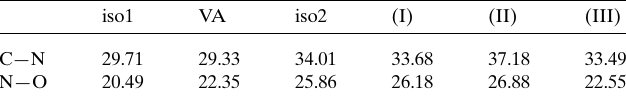
Figure 9 Distributed atomic polarizabilities of violuric acid ( a ) isolated, ( b ) taken from VA, ( c ) isolated ion, ( d ) taken from (I), ( e ) taken from (II), ( f ) taken from (III). The scaling factor is 0.4 A˚ (cid:5) 2 . Dashed lines indicate interactions with the oxime group, arrows indicate the direction of the hydrogen bond from donor to acceptor. Symmetry codes: (i) (cid:5) x + 1, (cid:5) y + 1, z + 1/2; (ii) (cid:5) x + 1/2, y (cid:5) 1/2, (cid:5) z ; (iii) x , y (cid:5) 1, z ; (iv) (cid:5) x + 1, (cid:5) y , (cid:5) z ; (v) (cid:5) x , y + 1/2, (cid:5) z + 1/2; (vi) (cid:5) x , (cid:5) y + 1, (cid:5) z + 1; and (vii) x , y + 1, z . Table 5 Bond polarizabilities for C5A–N2A and N2A–O1A in the studied compounds compared with values obtained for isolated molecules of violuric acid. Values are given in Bohr 3 . iso1 is an isolated molecule of violuric acid with an N–O–H group. iso2 is an isolated molecule of violuric acid with a deprotonated oxime